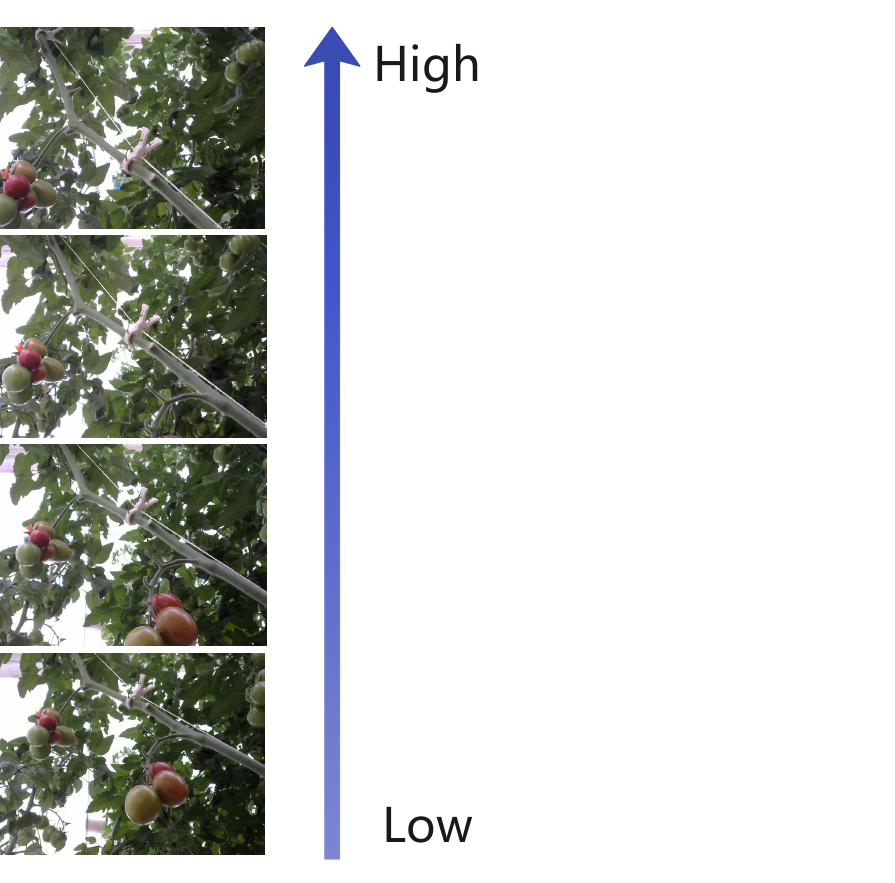
Figure 10. A part of the image data at a certain location. The order of image collection is from low to high, corresponding to low and high places in the real